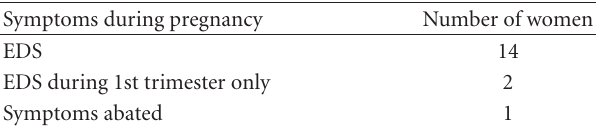
Table 5: Symptoms experienced during